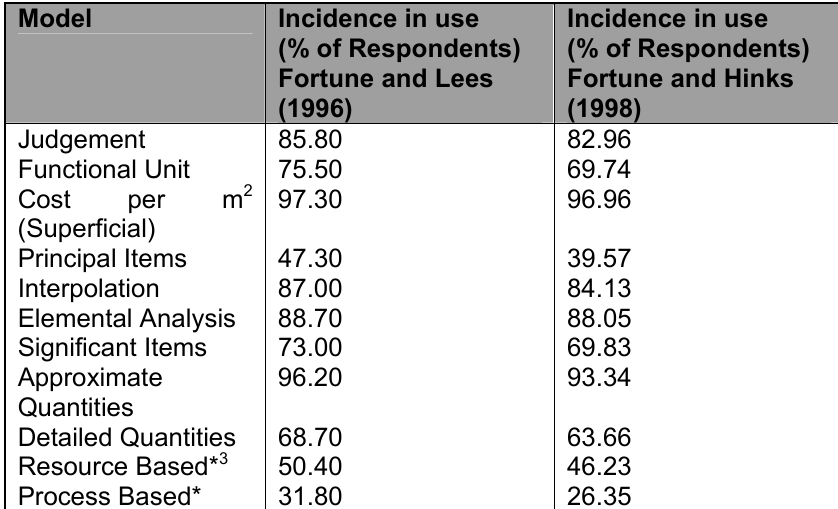
Table 4 - Use of various cost modelling techniques by Northern England “Organisations” (1996) and all England Quantity Surveyors (1998) (Source: Fortune and Lees, 1996. Fortune and Hinks,